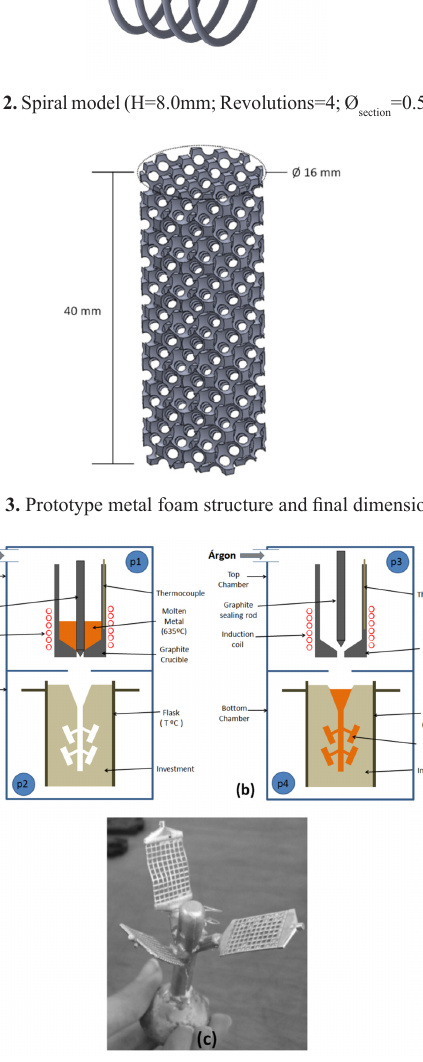
Figure 4. Shematic of lost wax casting procedure [(a) and (b)] used to obtain the metallic specimens of the development geometry and the metal foam prototype (c).